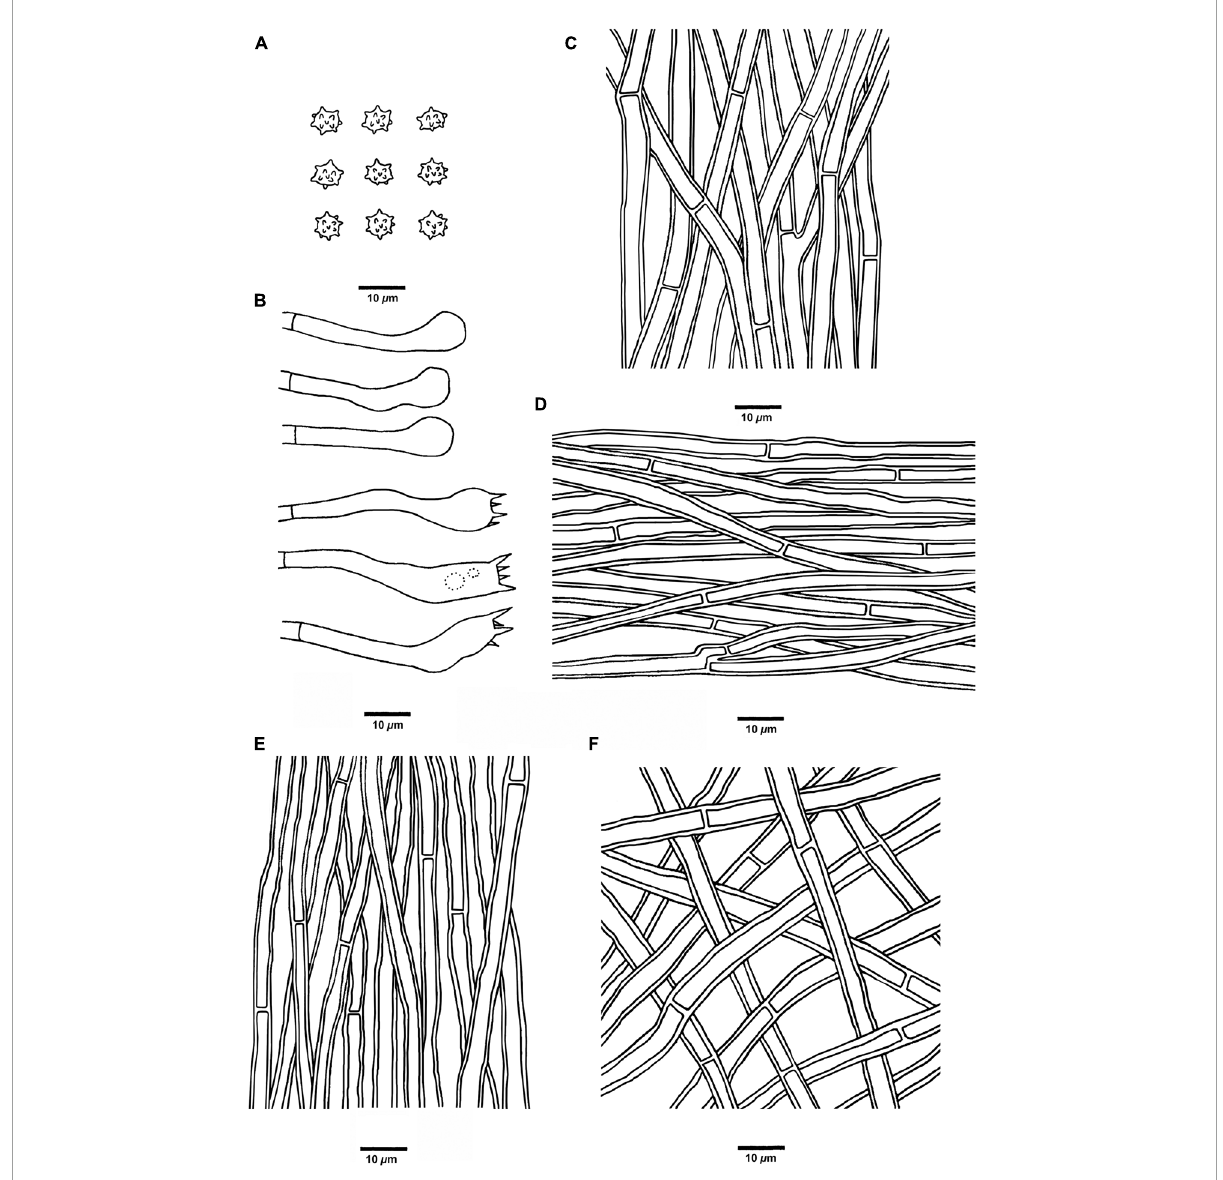
FIGURE5 Microscopic structures of H. chocolatum (drawn from Cui 18545). (A) Basidiospores, (B) Basidia and basidioles, (C) Hyphae from context, (D) Hyphae from spines, (E) Hyphae from the inner layer of stipe, and (F) Hyphae from the surface layer of